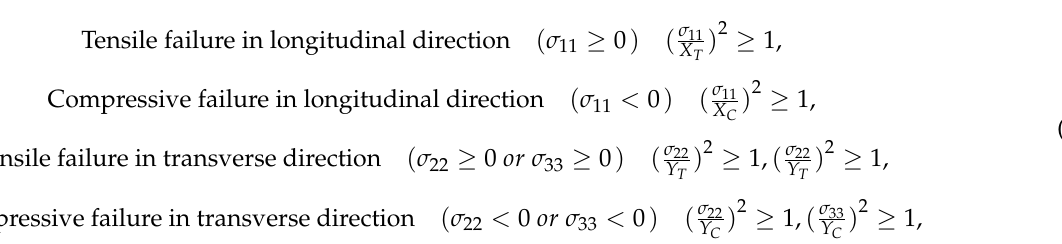
Damage initiation Figure 5. The response of the interface phase linear elastic separation under normal loading.